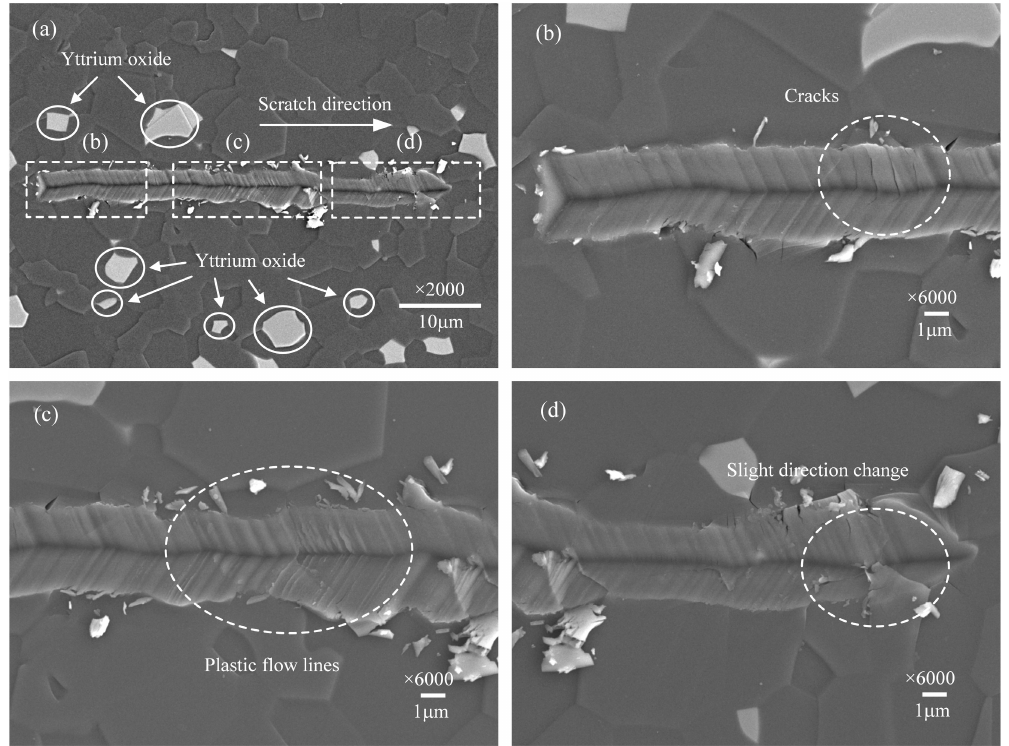
Figure 6. Surface morphology of the scratch groove at the scratch speed of 50 μ m/s. ( a ) is the overall morphology. ( b – d ) are detailed enlarged views.